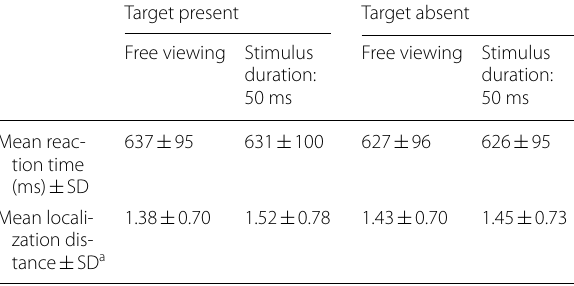
Table 2 Measures of the precision of the localizations in Experiment